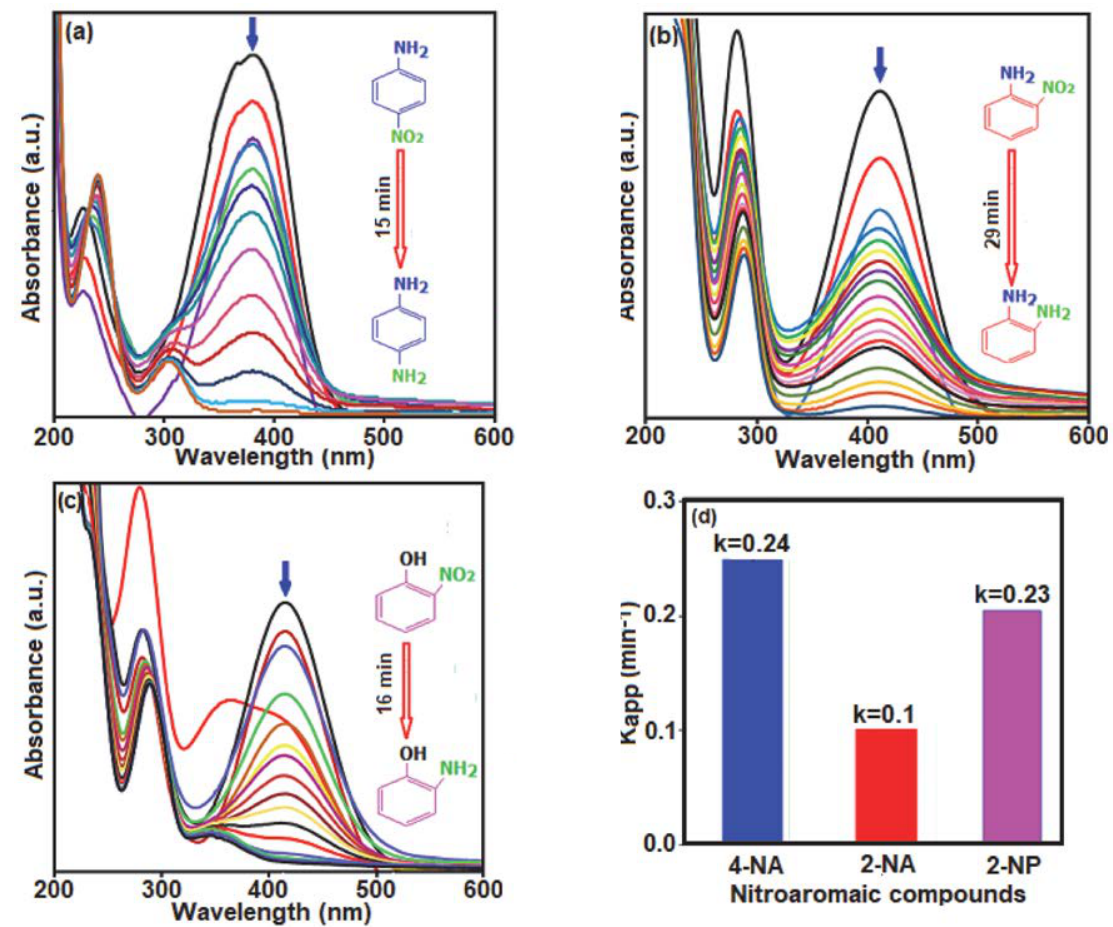
Figure 13. The UV–vis absorption spectra change for the reduction process of (a) 4-nitroaniline (4-NA), (b) 2-nitroaniline (2-NA), and (c) 2-nitro- phenol (2-NP) with NaBH 4 in the presence of Bi 2 O 2 CO 3 /CoFe 2 O 4 30% catalyst. (d) the calculated apparent rate constant values. Conditions: catalyst (5.0 mg), NaBH 4 (0.5 mL, 20 mM), and nitro compound (2 mL, 0.2 mM) at 25